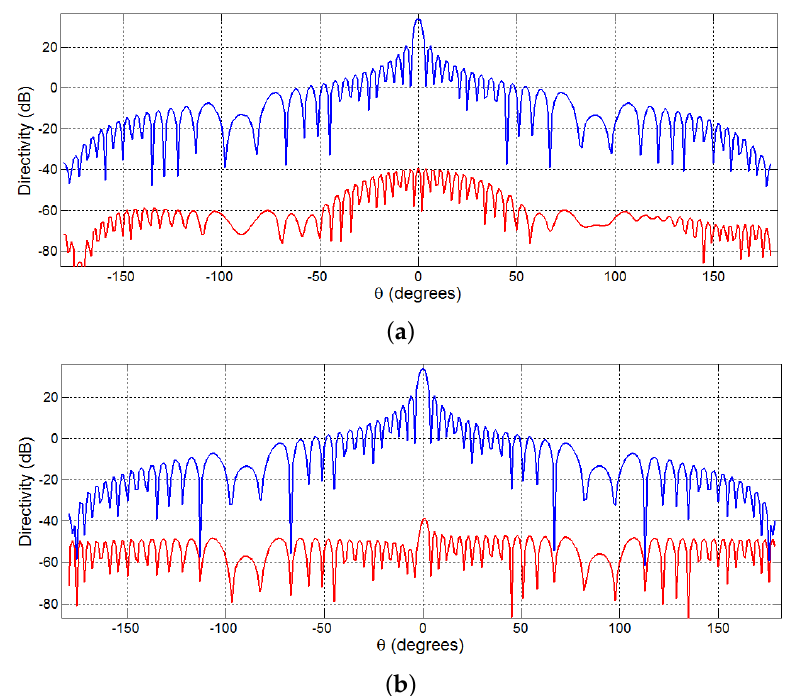
Figure 18. Principal plane cut of 32-by-32 array simulations using the PASim program. The blue and red plots are respectively co-polar and cross-polar directivity patterns of each principal plans. ( a ) Horizontal principal plane cut; ( b ) Vertical principal plane